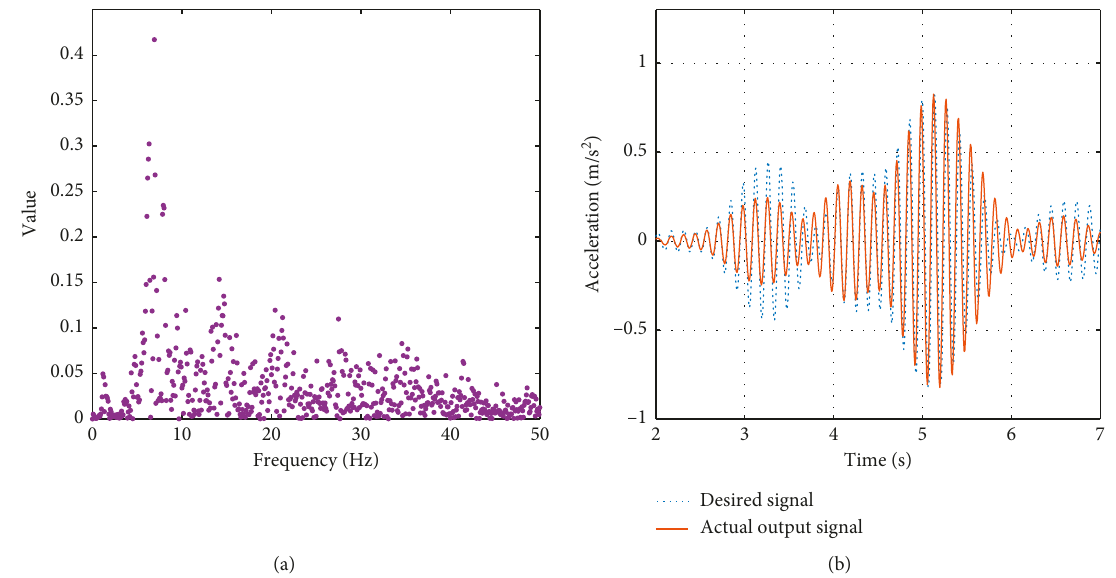
Figure 21: (a) Relative frequency error and (b) filtered time-history comparison of the desired signal and actual output signal of